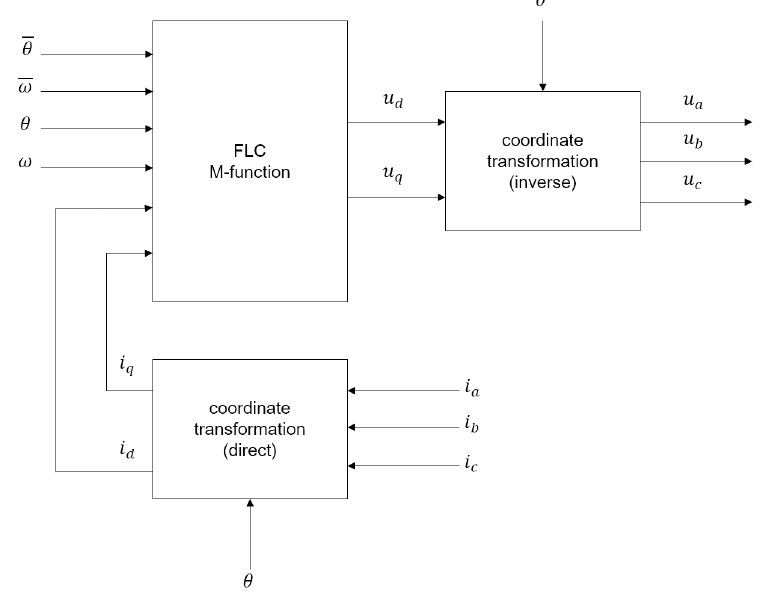
Figure 8. Block diagram of the control